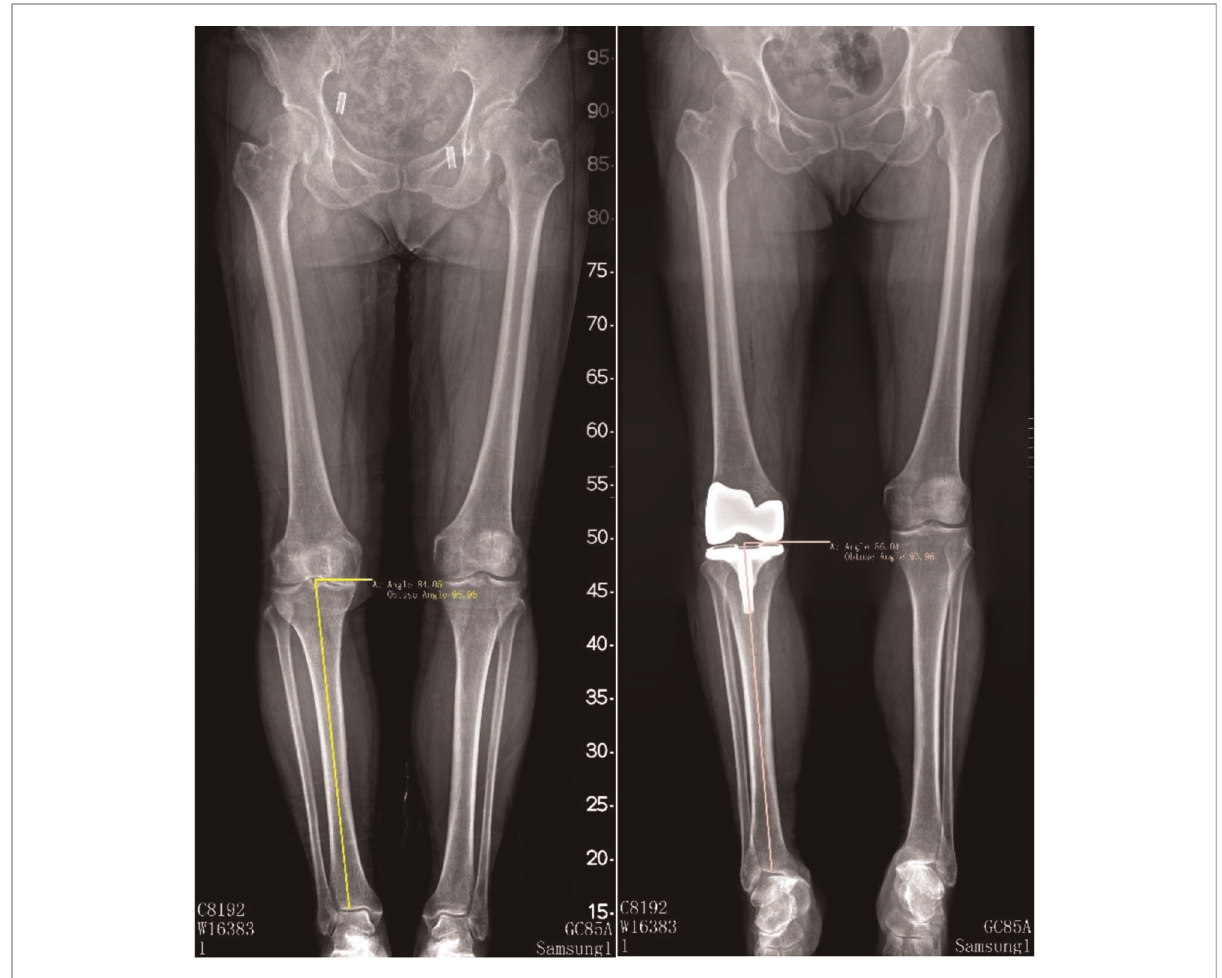
FIGURE 5 Pre-operation and post-operation MPTA measurement